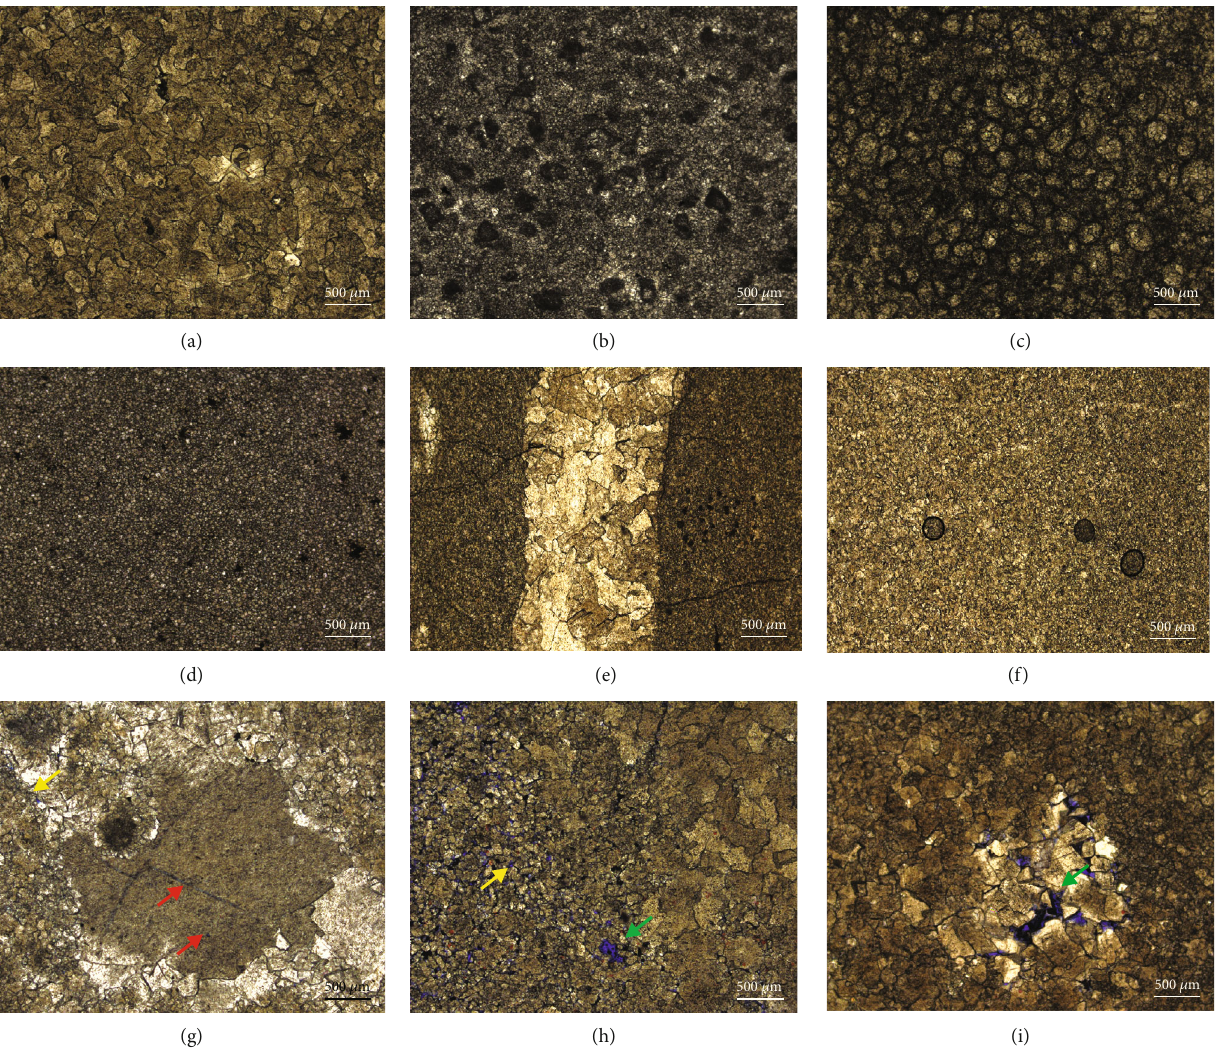
Figure 3: Thin sections of outcrop samples from di ff erent sections of the Xiaoerbulake Formation, Tarim Basin; observed by optical microscopy under a polarized light: (a) fi ne-medium grained dolomite, no evidence of pores, SHY 5-107-3; (b) doloarenite, fi ne-grained dolomite cementing the space between grains, SGT 6-56-2; (c) microbial dolomite (spongy layered dolomite), multigeneration, and multistage dolomite fi lling the dissolution pores, SHY 6-133-1; (d) micritic dolomite, bitumen fi lling some dissolution pores, SGT 4-30-E; (e) micritic dolomite, calcite fi lling the microfracture, SHY 3-041-3; (f) fi ne grained dolomite, few fabric dissolution pores fi lled by bitumen, SHY 3-041-3; (g) fi ne-medium grained dolomite, intragranular pores and microfractures (red arrows) in the grain, intergranular pores in the matrix dolomite (yellow arrow), SGT 5-47-A; (h) intergranular pores in the dissolved dolomite (yellow arrow) and intercrystalline pores (green arrow), SHY 4-091-D; (i) intercrystalline dissolution pores (green arrow) in the fi lling dolomite, SHY